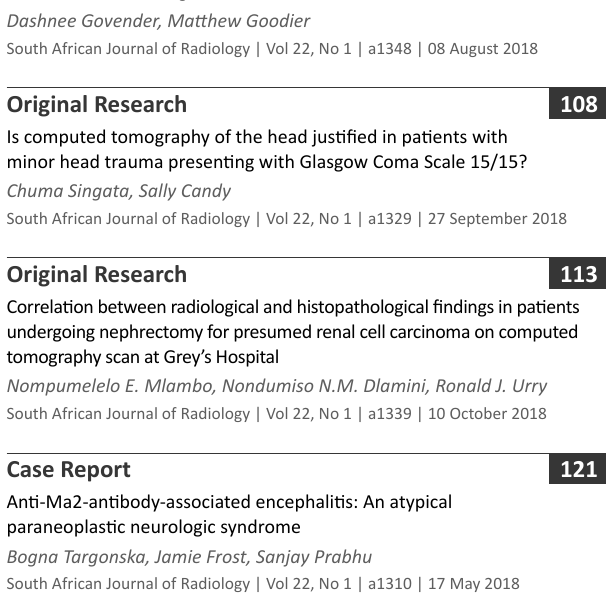
Pictorial essay: Computed tomography findings in acute aortic syndromes